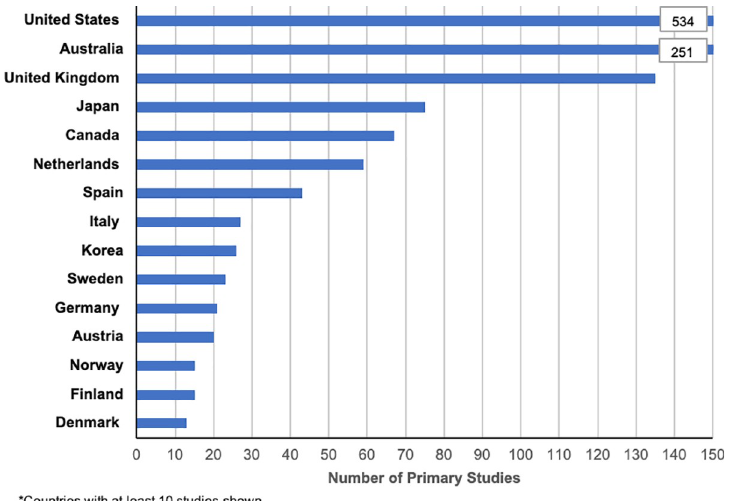
Fig 2. Origin of primary studies included in